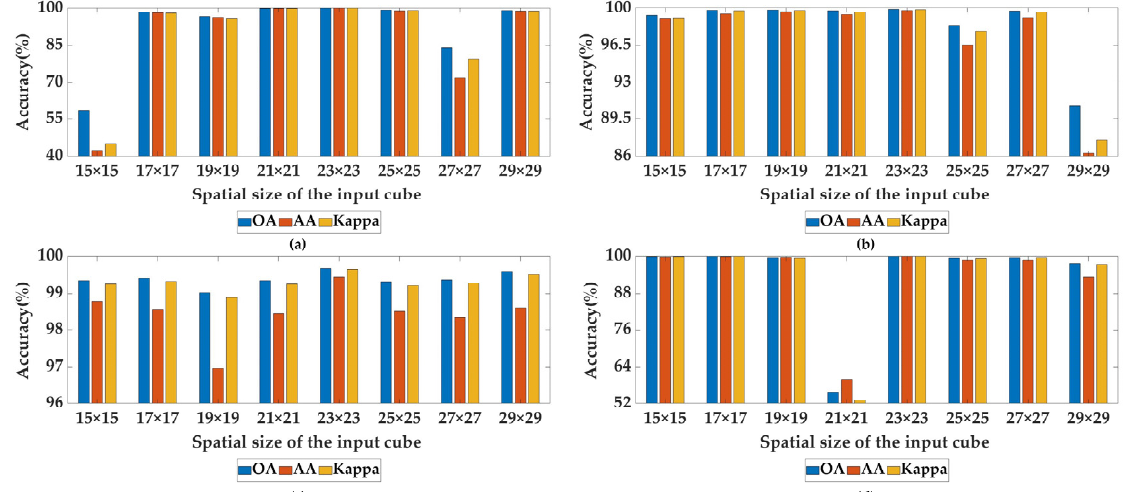
Figure 11. The classification results of different spatial sizes of image cube. ( a ) on the SAC dataset, ( b ) on the UP dataset, ( c ) on the IP dataset, ( d ) on the SA dataset.